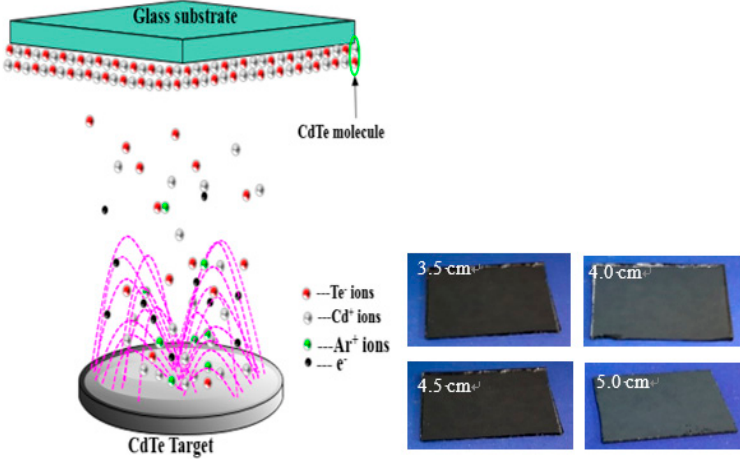
Figure 1. Schematic diagram of the sputtering process of cadmium telluride (CdTe) films.